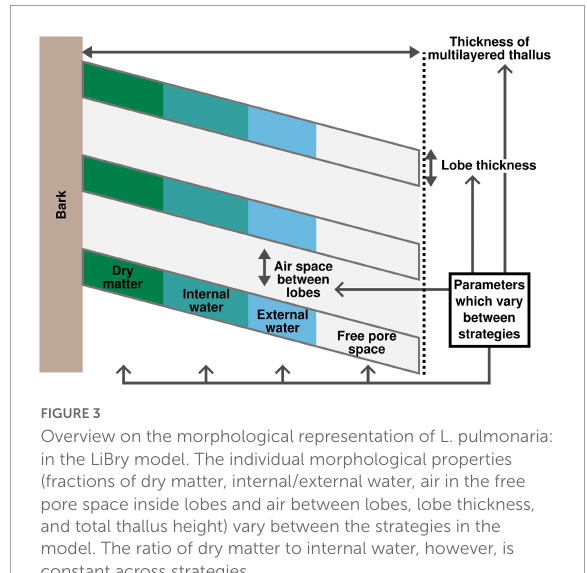
FIGURE3 Overview on the morphological representation of L. pulmonaria: in the LiBry model. The individual morphological properties (fractions of dry matter, internal/external water, air in the free pore space inside lobes and air between lobes, lobe thickness, and total thallus height) vary between the strategies in the model. The ratio of dry matter to internal water, however, is constant across